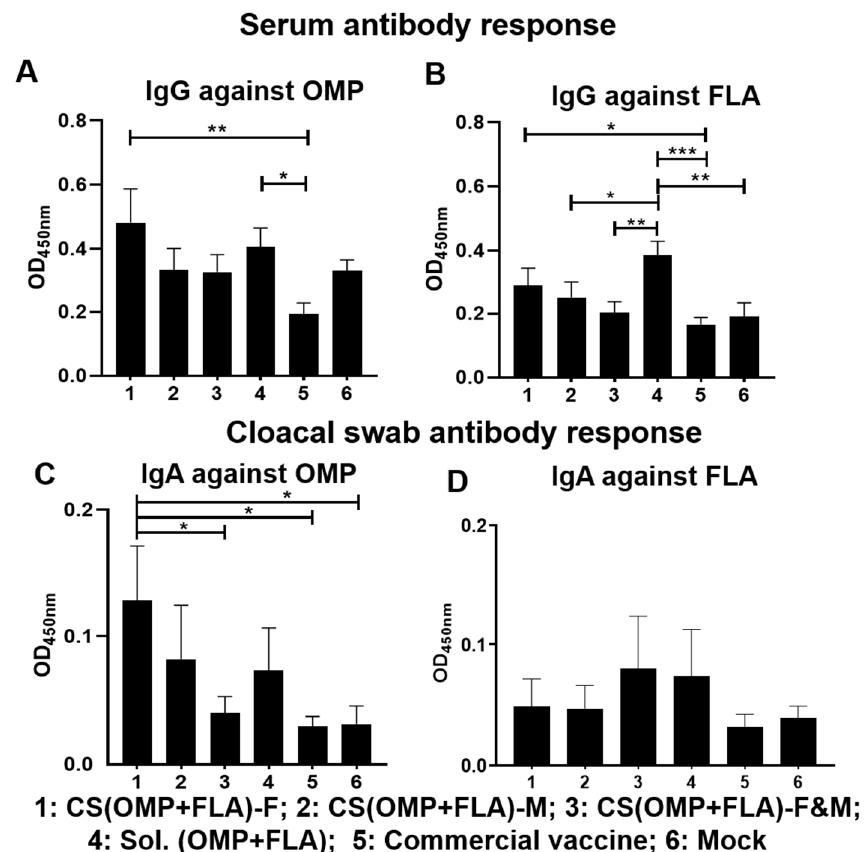
Figure 1. Post-vaccination Salmonella antigens’ specific IgG and IgA antibody responses. Broilers were vaccinated with CS(OMP + FLA)-F, CS(OMP + FLA)-M and CS(OMP + FLA)-F&M orally at age 3 days, with each dose containing 10 µ g (OMP + FLA), followed by a booster dose at age 3 weeks. The control birds received mock saline, 10 µ g of Sol.Ag (OMP + FLA) and commercial live Salmonella vaccine orally on the same days of our candidate vaccines schedule. Blood and cloacal swab samples collected at week 5 (2 weeks after booster) post-vaccination were analyzed for detection of specific IgG and IgA antibodies, respectively, by ELISA. Serum samples were analyzed for IgG antibody response against ( A ) OMP and ( B ) FLA protein. Cloacal swabs were analyzed for IgA antibody response against ( C ) OMP and ( D ) FLA protein. Data are presented as the mean ± SEM of 6 to 13 birds per group. Significant di ff erences were determined by one-way ANOVA followed by Tukey post-hoc test between each of the groups. Only significant di ff erences are labelled in the figures (* p < 0.05, ** p < 0.01, and *** p < 0.001).